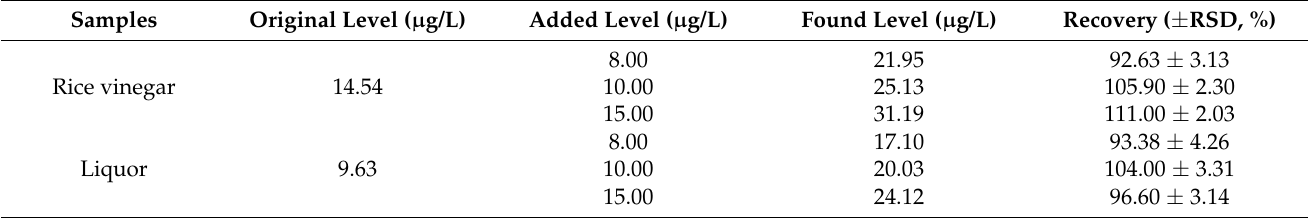
Figure 4. ( a ) CE peak area of the 50.0 μg/L histamine solution with no treatment (A), or MISPE cartridge (B), NIP cartridge (C) and C 18 cartridge (D) as the pre-treatment procedure. ( b ) CE peak area of 0.1 μg/L histamine (A), tryptamine (B) and phenylethylamine (C) when using MIP and NIP as the SPE sorbent. ( c ) CE peak area of the histamine in the absence of interferants (A), and presence of a 5-fold concentration of arginine (B) and lysine (C), 100-fold concentration of glucose (D) and 50-fold concentration of Na + (E), K + (F), CH 3 COO − (G) and Cl − (H) in 0.1 μg/L histamine solution which detected by the MISPE-CE method. Table 1. Recovery test results for the determination of histamine in spiked rice vinegar and liquor samples using the MISPE-CE method ( n =